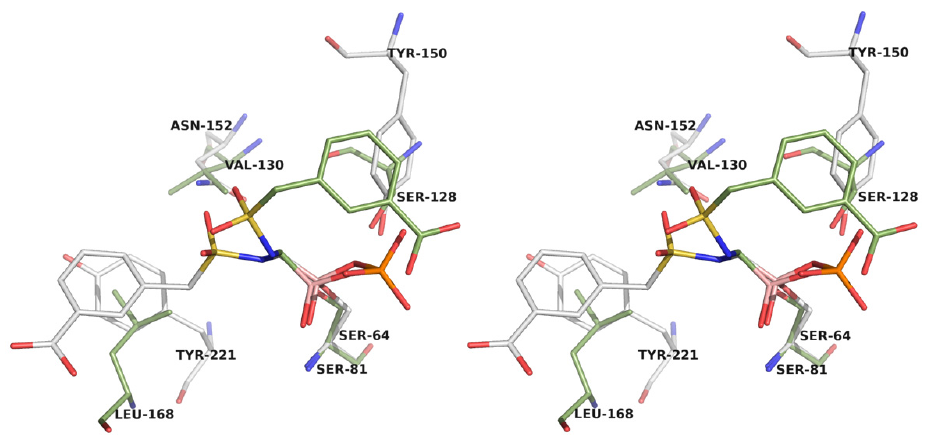
Figure 5. Stereoview superposition of class D OXA-24/40 (carbons colored smudge green) and class C ADC-7 (carbons colored white) in complex with CR167 . The BATSI adopts a different binding mode within the active sites of the two different enzyme classes.